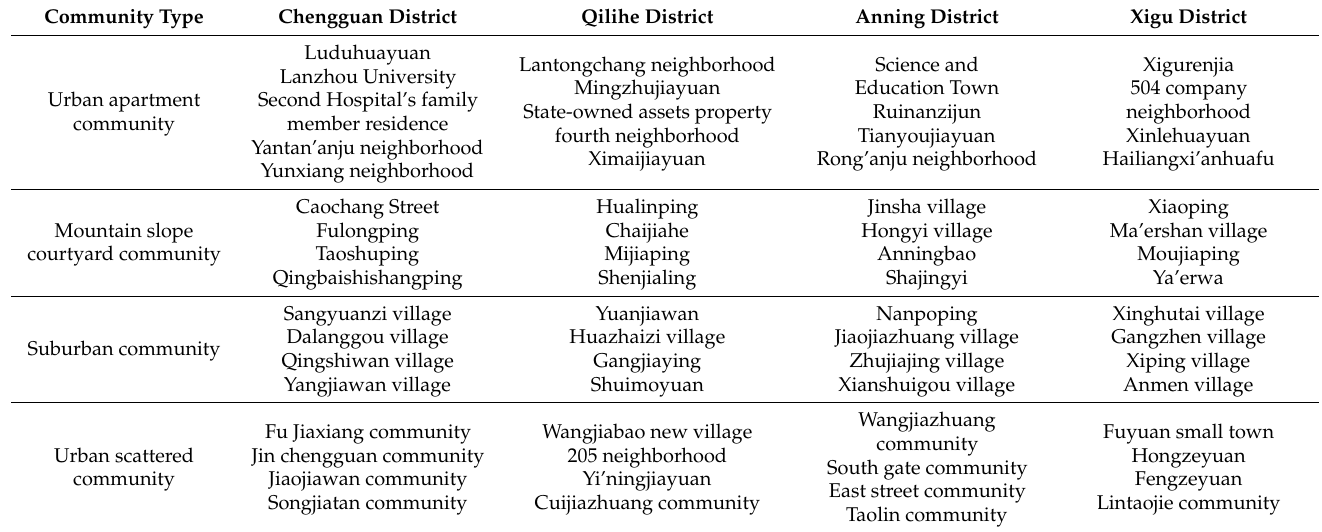
Table A1. Case communities in Lanzhou.